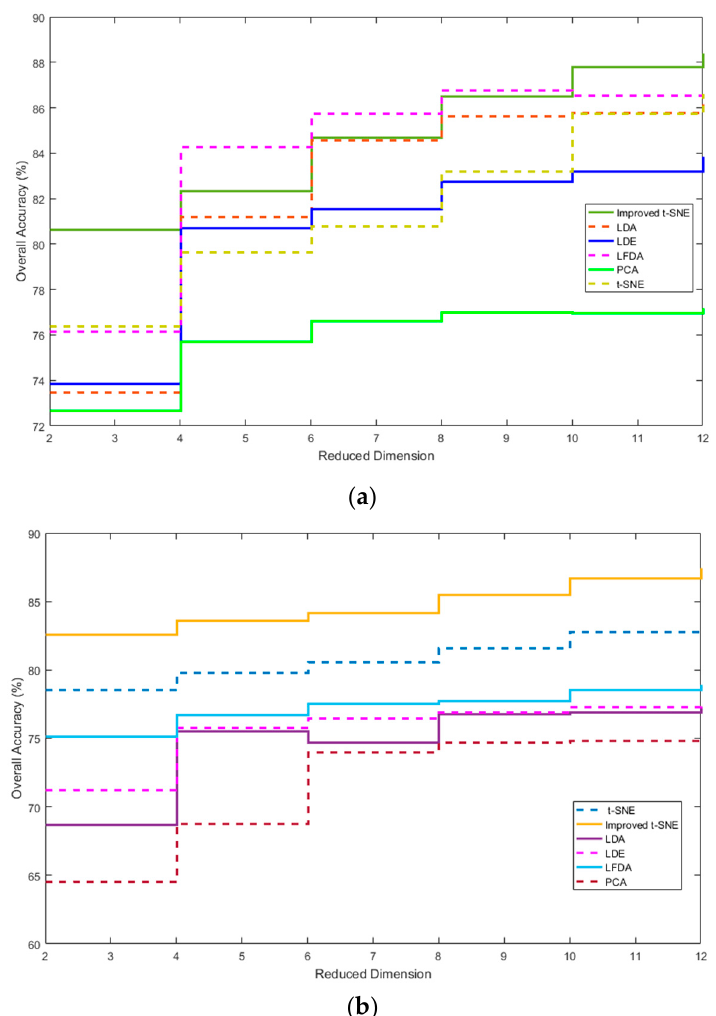
Figure 10. Comparison of different DR algorithms with various reduced dimensions, from 2 to 12: ( a ) university scene; and ( b ) city center scene.